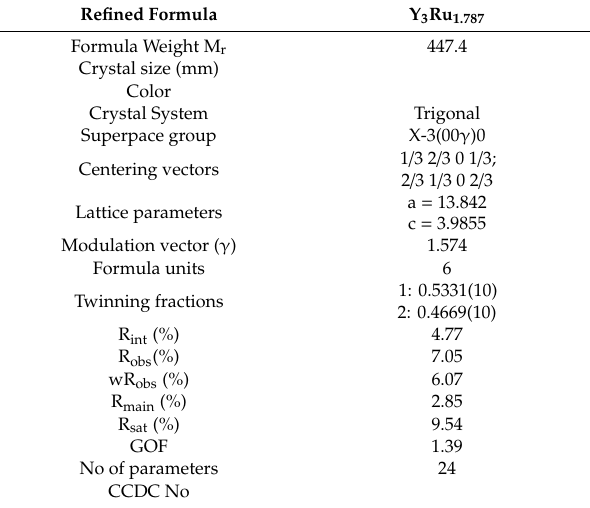
Figure 1. Reconstructed 0klm layer from the single crystal experiment. Sublattice reflections up to hk03 (yellow) and hk40 (red) are visible, as are mixed satellites (white). Di ff use scattering is visible for the hk01 layer and more prominent for the hk02 layer. Table 1. Crystallographic data for